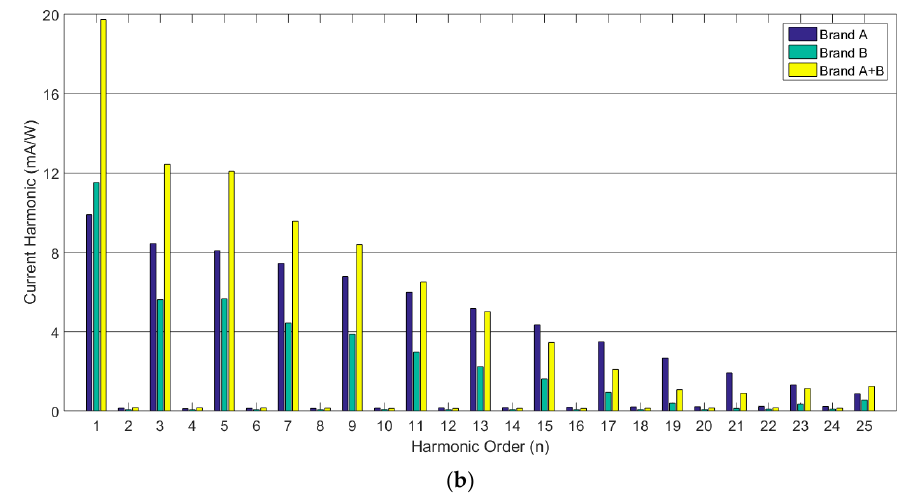
Figure 8. Comparison of harmonic spectrum for case of eight LED lamps with eight drivers among different brands of LED lamp. ( a ) Harmonic spectrum of LED lamp (%f); ( b ) Harmonic spectrum of LED lamp (mA/W).